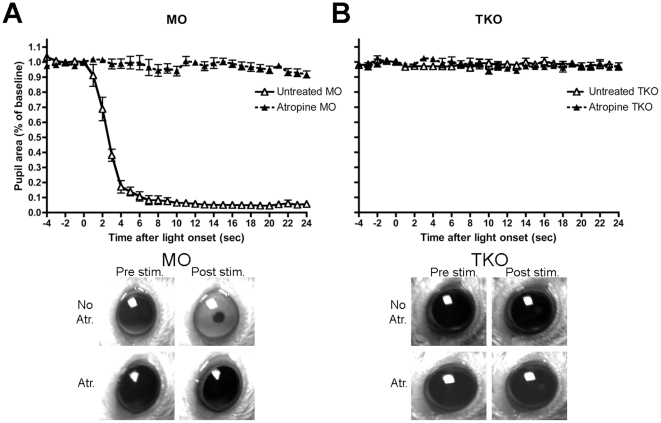
Effect of atropine on pupil size.In (A) MO (rd/rd cl), and (B) TKO (Opn4−/− Gnat1−/− Cnga3−/−) mice. Images below each graph illustrate pupil size pre- and post- light stimulation with atropine (Atr.) or without atropine (No Atr.) application in the two genotypes.